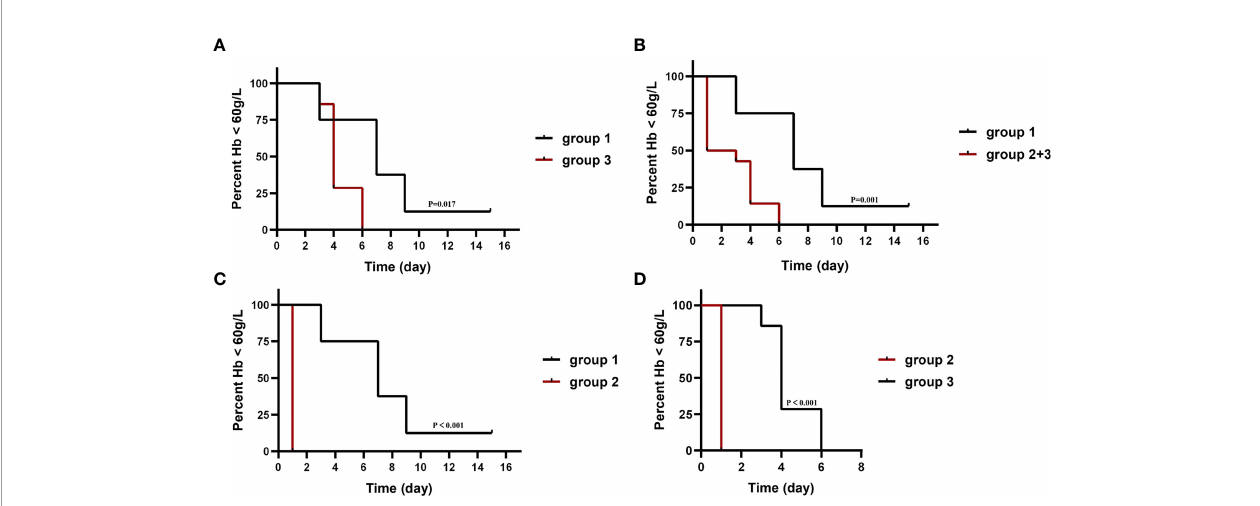
TABLE 2 | The key factor for initiating WBE identi fi ed by binary logistic regression